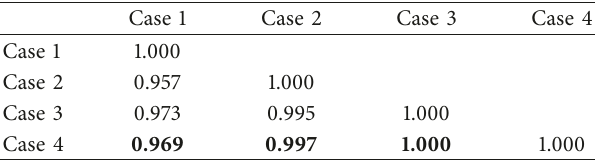
Table 9: Mean link travel time. Table 10: Coefficients of correlation of mean link